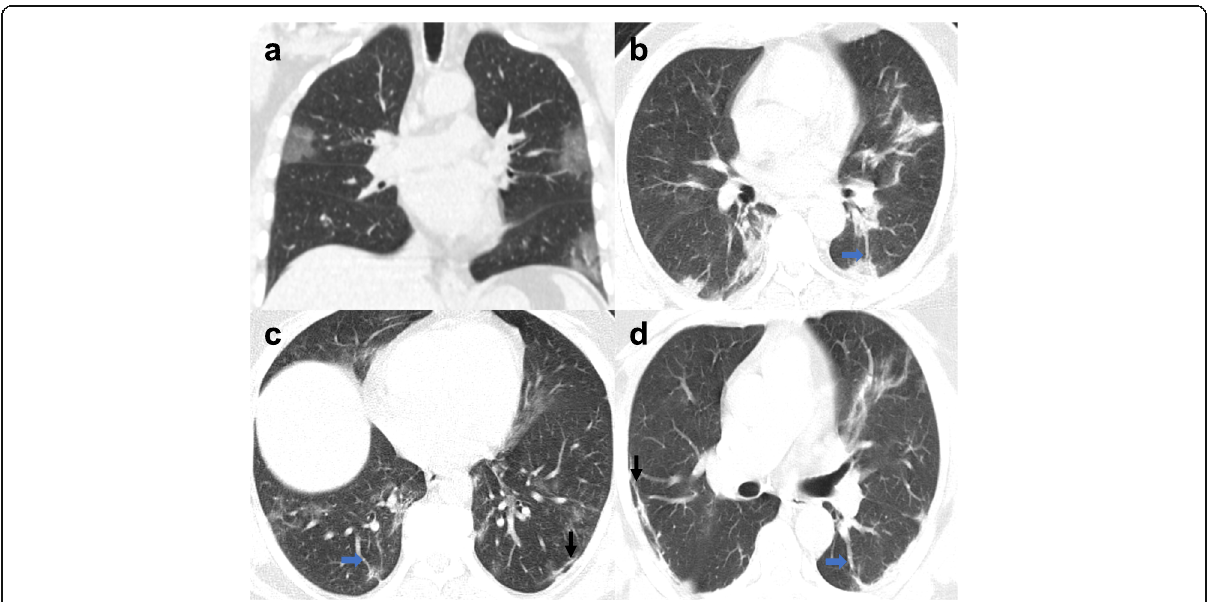
Fig. 2 Two-dimensional coronal reconstruction ( a ) and axial CT image lung window ( b , c ) in two different cases with COVID-19 pneumonia, showing the typical appearance of bilateral peripheral patchy ground-glass densities ( a , c ) and/or consolidations ( b ), subpleural band (black arrows), and vascular dilatation (blue arrows)